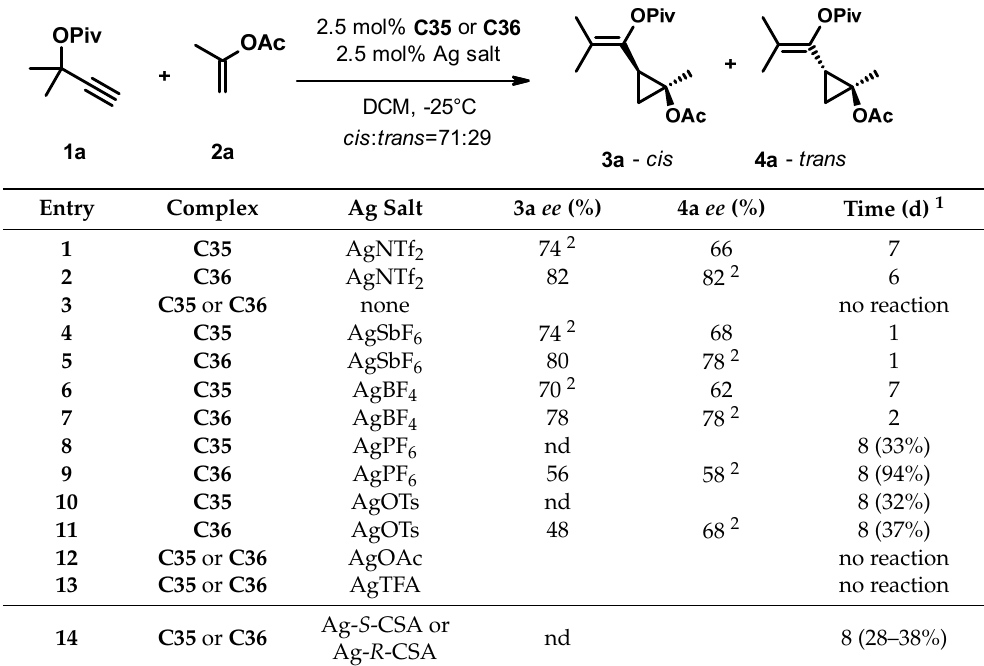
Table 2. The effect of the added silver salt on the asymmetric cyclopropanation.